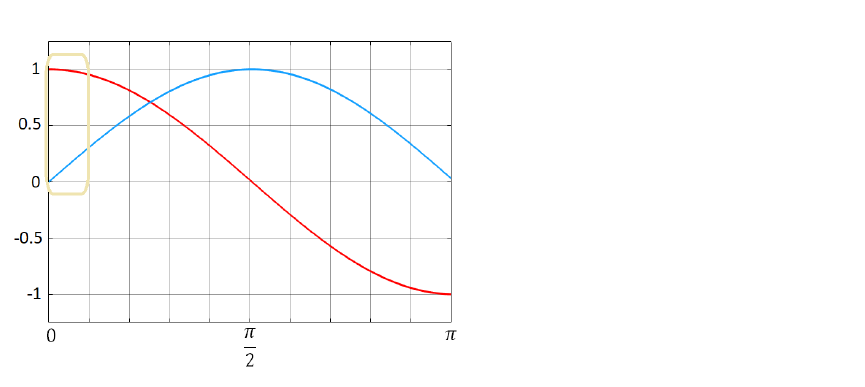
Figure 5. The method of active and reactive power calculation. ( a ) System with standard three phase-based PLL signal. ( b ) System with three individual PLL signals, which is the proposed method for the presence of angular asymmetry between voltage vectors.